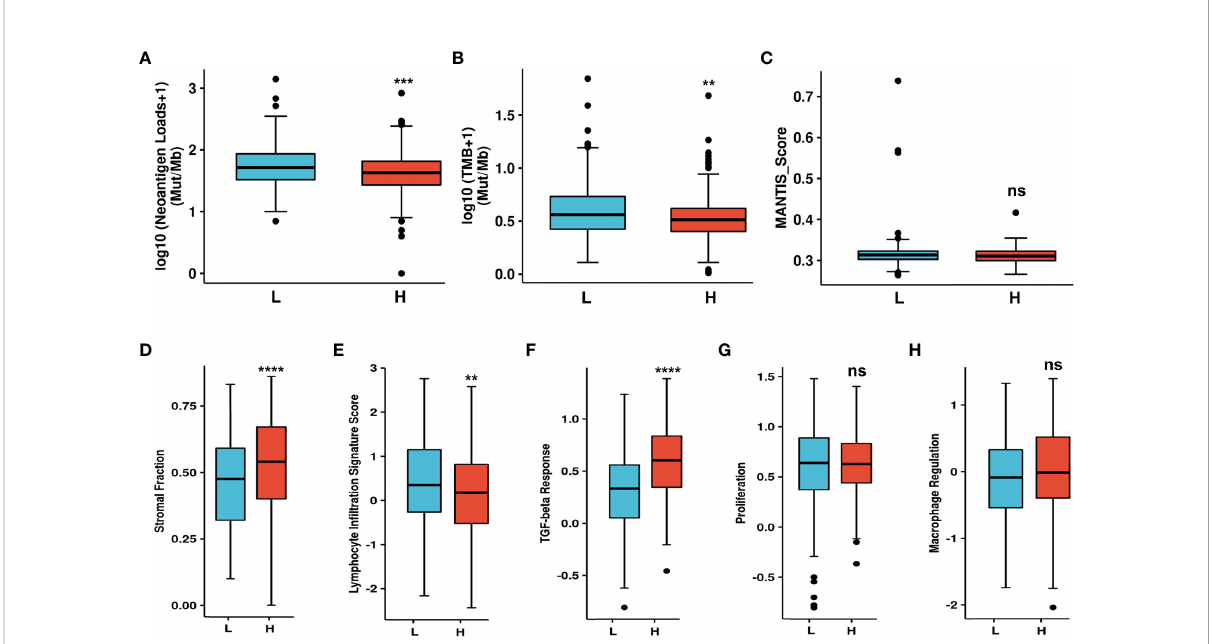
FIGURE 6 Upregulated NT5E predicts unique tumor microenvironment. (A) NAL comparison between NT5E-high and NT5E-low group. (B) TMB comparison between NT5E-high and NT5E-low group. (C) MANTIS score comparison between NT5E-high and NT5E-low group. (D) Stromal fraction comparison between NT5E-high and NT5E-low group. (E) Lymphocyte in fi ltration signature score comparison between NT5E-high and NT5E-low group. (F) TGF-beta response comparison between NT5E-high and NT5E-low group. (G) Proliferation comparison between NT5E- high and NT5E-low group. (H) Macrophage regulation comparison between NT5E-high and NT5E-low group. (ns, p ≥ 0.05, ** p < 0.01, ***p < 0.001, **** p <